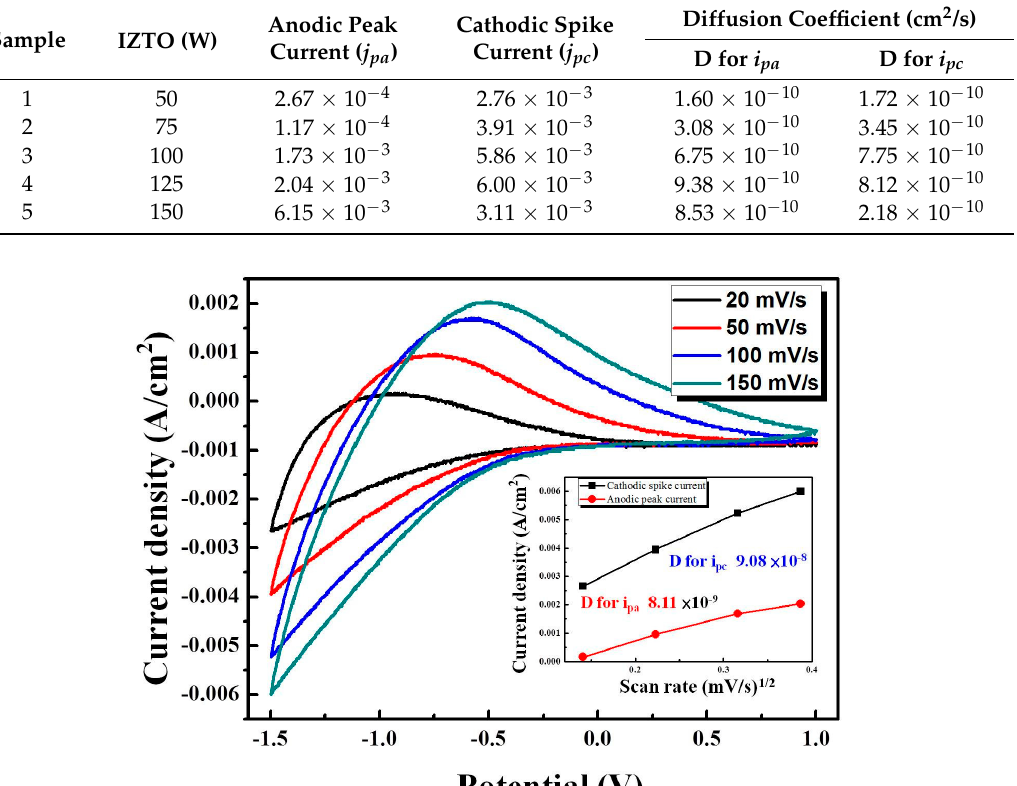
Figure 8. The CV curves of the 50th cycle of WO 3 /IZTO films at 125 W for various scan rates ranging from 20 to 150 mVs − 1 .